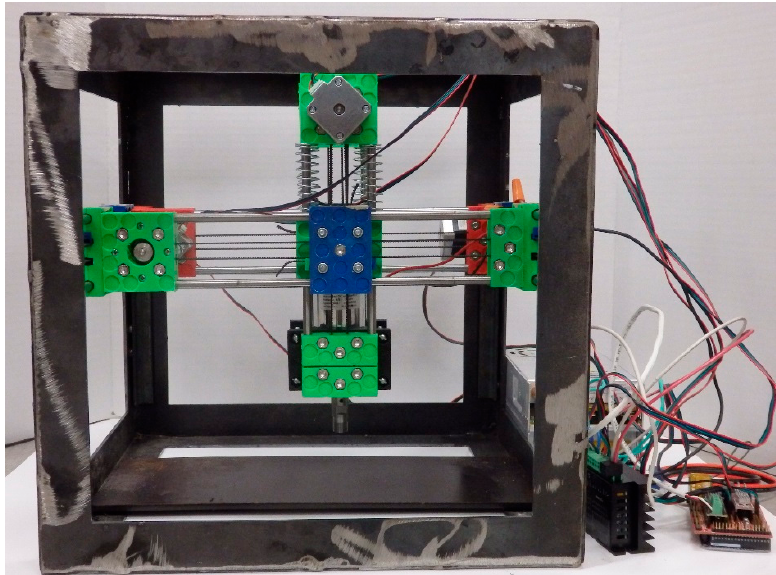
Figure 9. An image of the completed circuit mill.